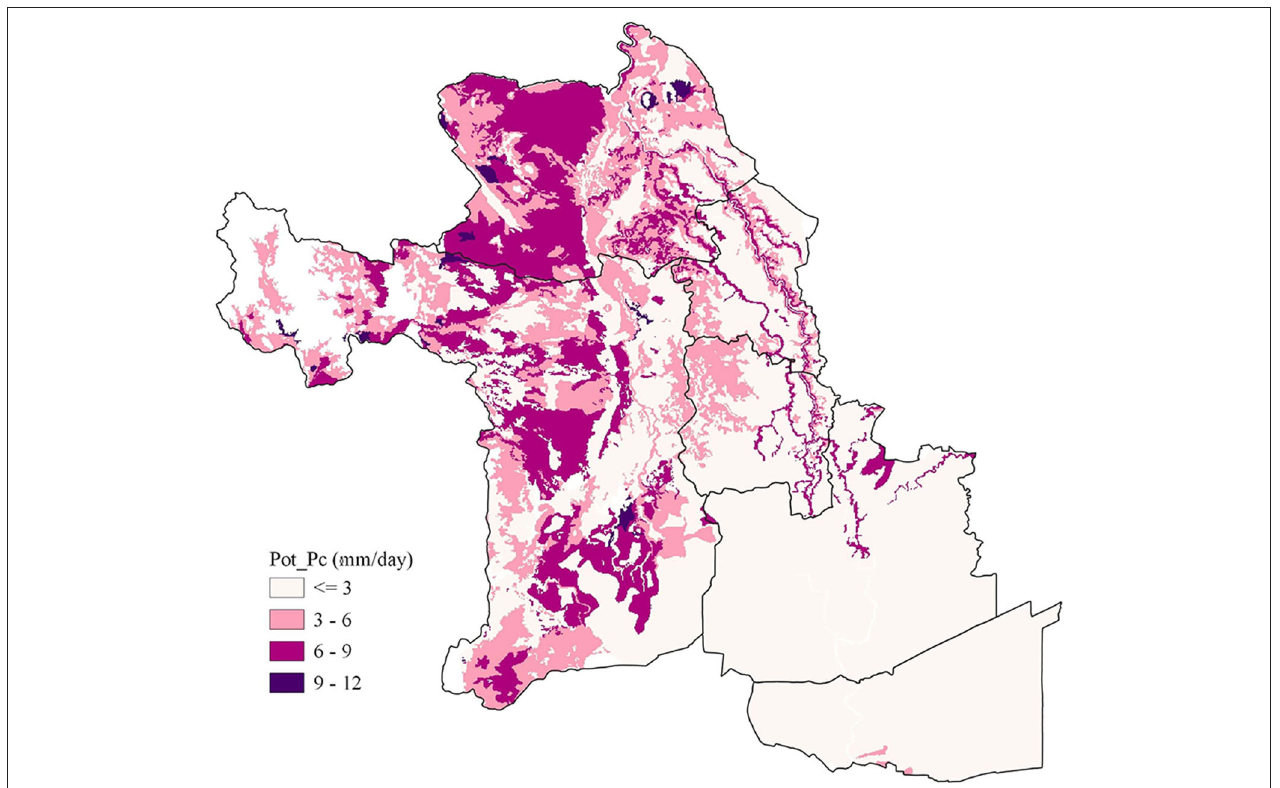
FIGURE 5 | Spatial distribution of potential percolation rates (Pot_Pc) at basic setting in the target area.